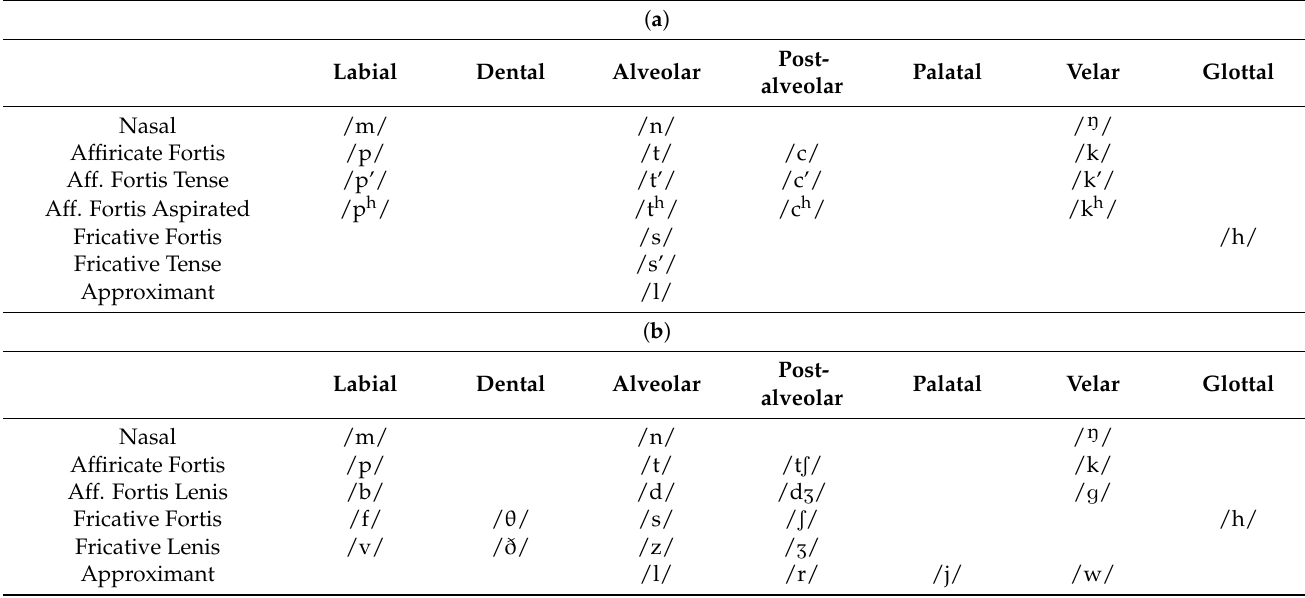
Table 1. Difference of consonants map: ( a ) Korean 1 ; ( b ) American English.